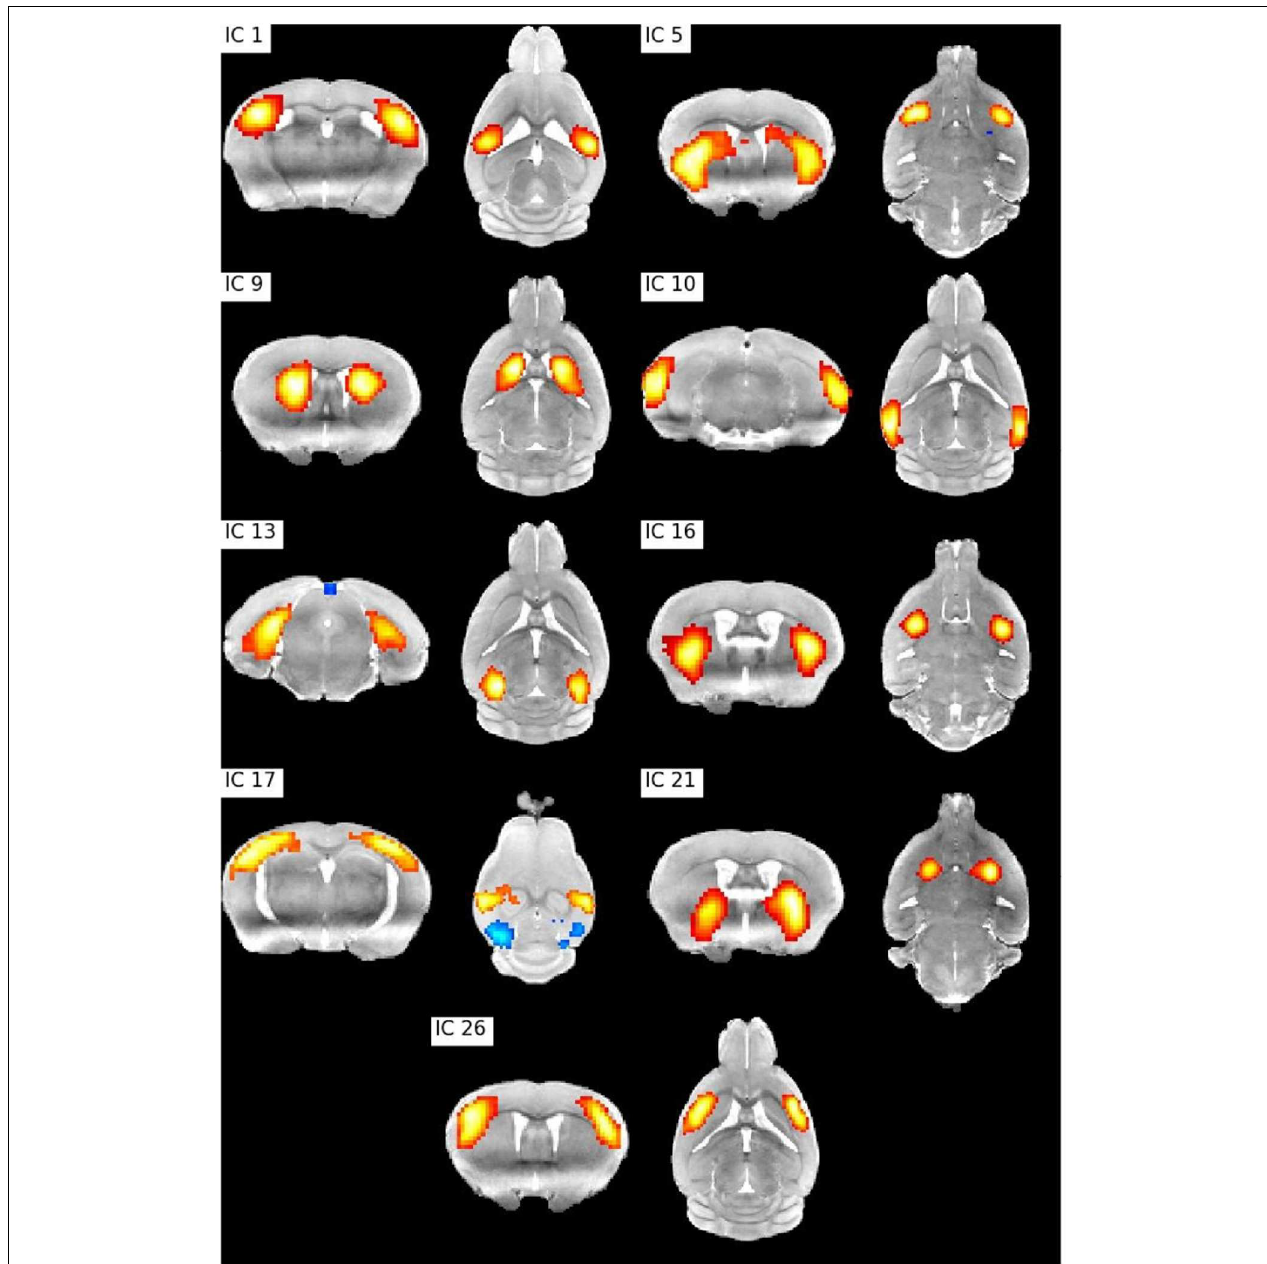
FIGURE 6 | ICA bilateral components. IC 1: Barrel field (i) cortex, IC 5: Lateral striatum, IC 9: Dorsal striatum (i), IC 10: Visual cortex, IC1 3: Hippocampus, IC 16: Dorsal striatum (ii), IC 17: Barrel field (ii) cortex, IC 21: Ventral striatum, IC 26: Supplementary cortex.